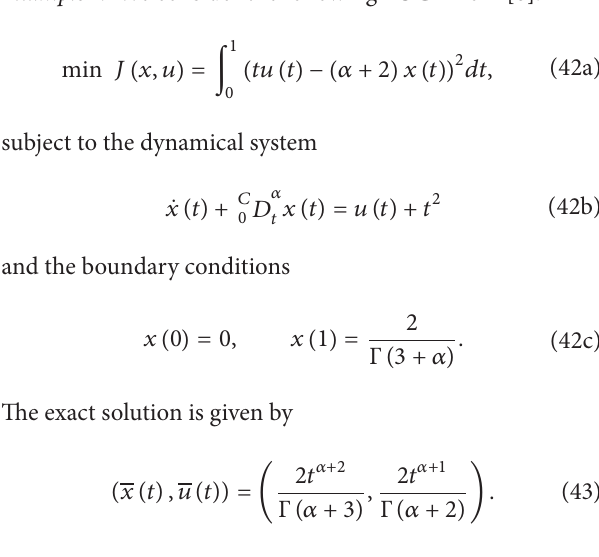
Algorithm A . The first algorithm for the solution of (42a)– (42c) follows the “optimize first, then discretize”